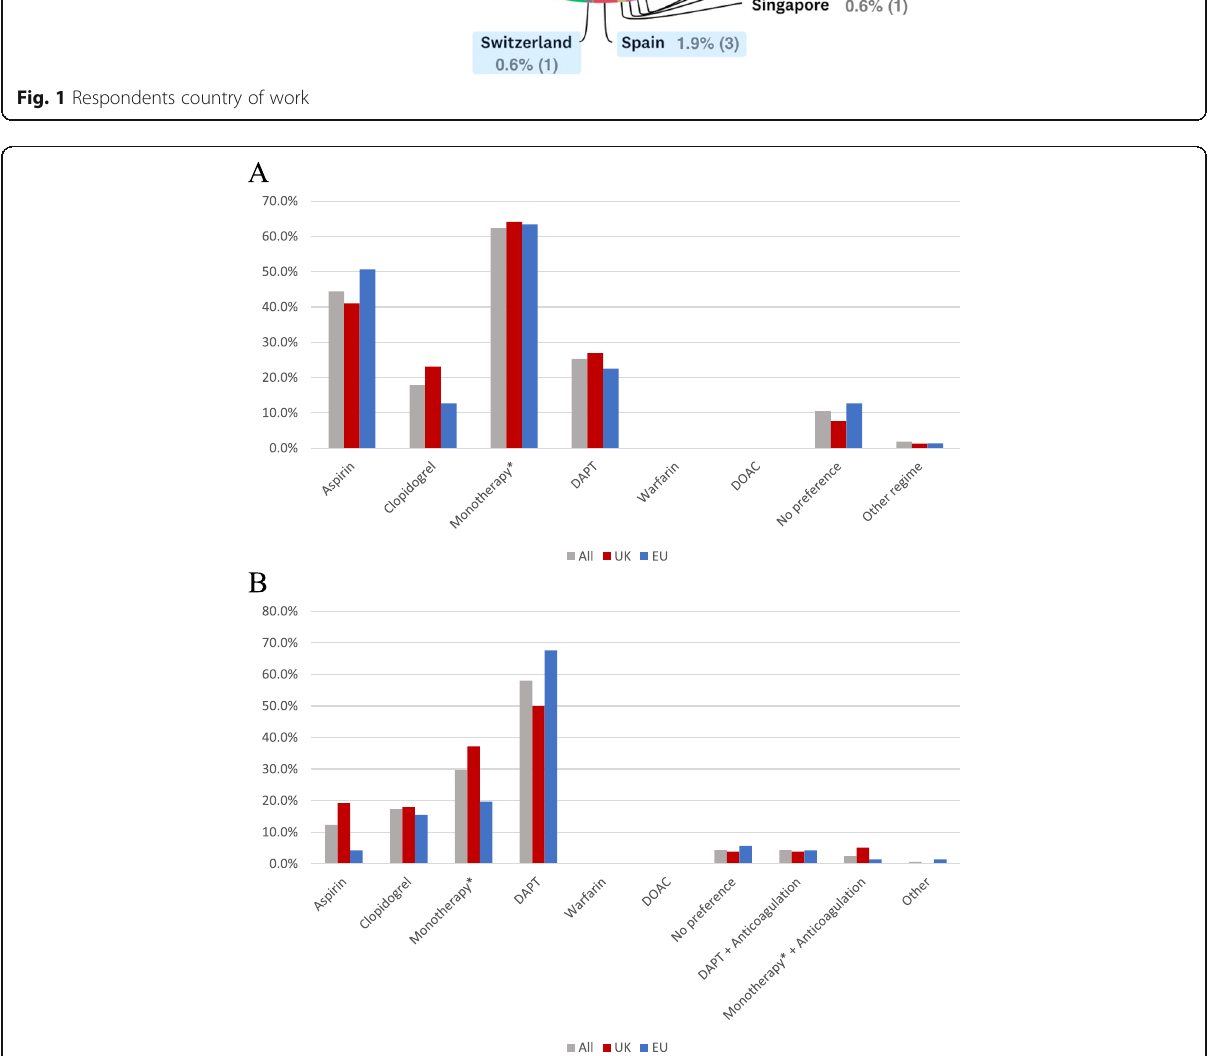
Fig. 2 Respondent preference for pre ( a ) and post ( b ) procedural antithrombotic therapy. Legend: DAPT dual antiplatelet therapy. DOAC direct oral anticoagulant. *Monotherapy = composite of aspirin, clopidogrel and ‘ other regime ’ where an antiplatelet agent was